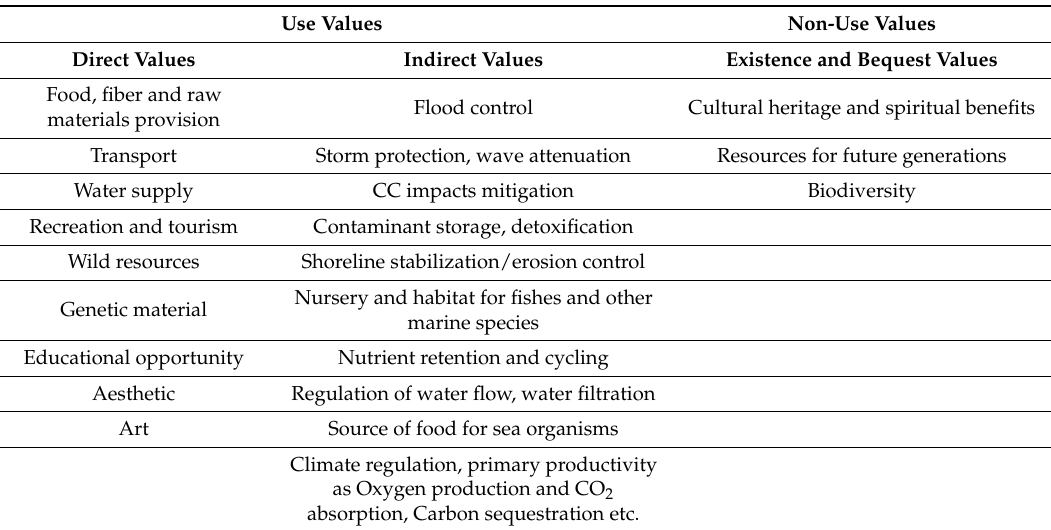
Table 1. Values provided by coastal and marine ecosystem services.